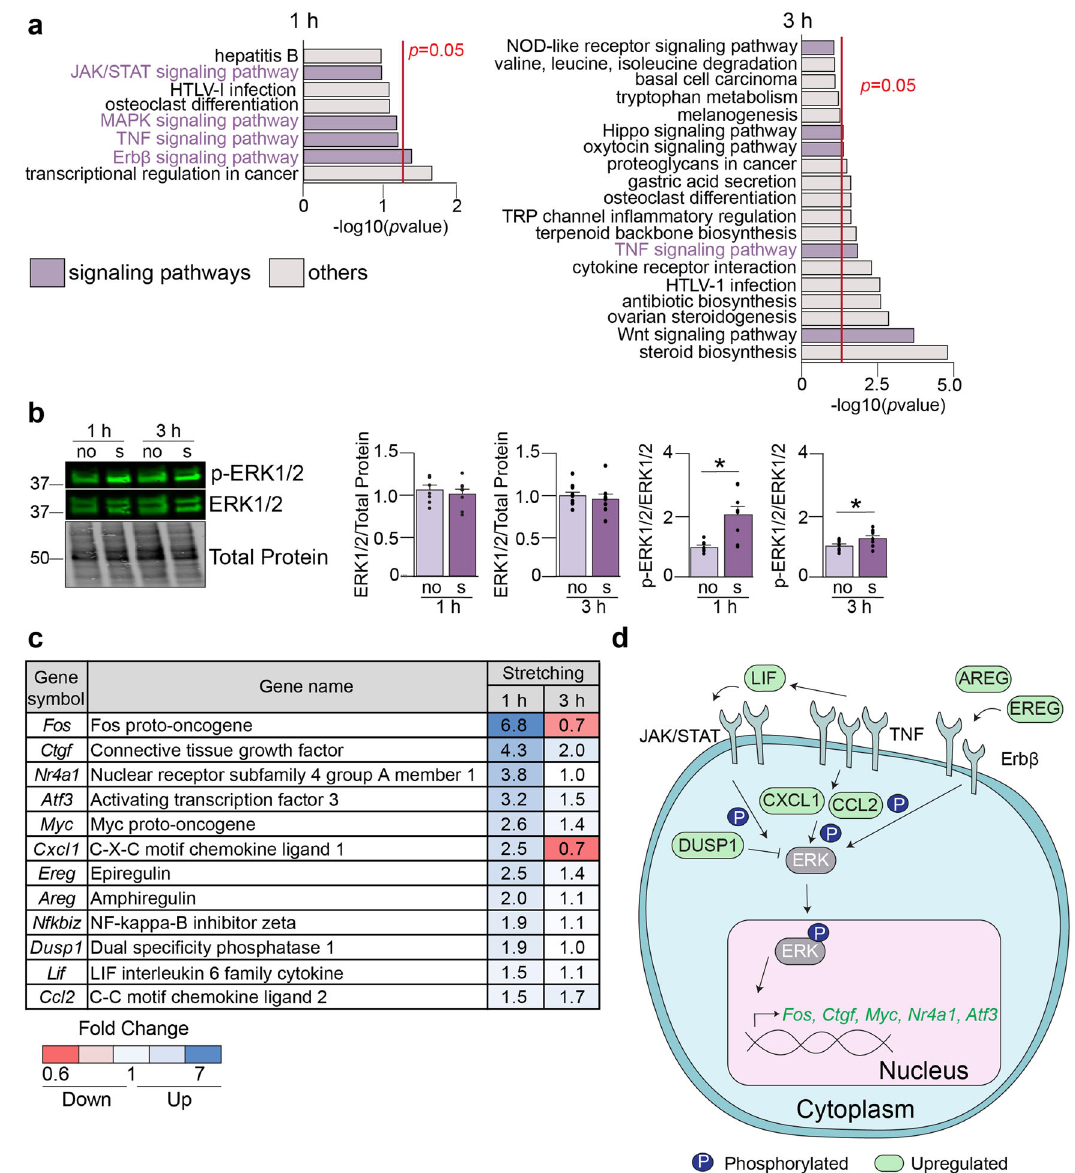
Fig. 2 Stretching induces activation of the MAPK pathway. a Pathway analysis of the differentially expressed genes in response to stretching in differentiated cells was performed using DAVID (Database for Annotation, Visualization, and Integrated Discovery). Red lines indicate p -values<0.05. b Differentiated muscle cells were stretched for 1h or 3 h. Western blot assays were performed and quanti fi ed by densitometry to examine total ERK1/2 and phosphorylated ERK1/2 (p-ERK1/2) levels. Results are shown as mean± SEM, N = 3, * p < 0.05, Welch ’ s T -test. c mRNA expression changes of various genes encoding proteins involved in signaling pathways linked to ERK1/2 using RNA-seq data (differentiated cells). The fold change was de fi ned as the ratio between stretched and non-stretched samples. Values above 1 indicate upregulated genes and values below 1 indicate downregulated genes. d Cartoon depicting the genes activated by cell stretching to illustrate how the MAPK pathway may be activated. no: non-stretched samples. s: stretched